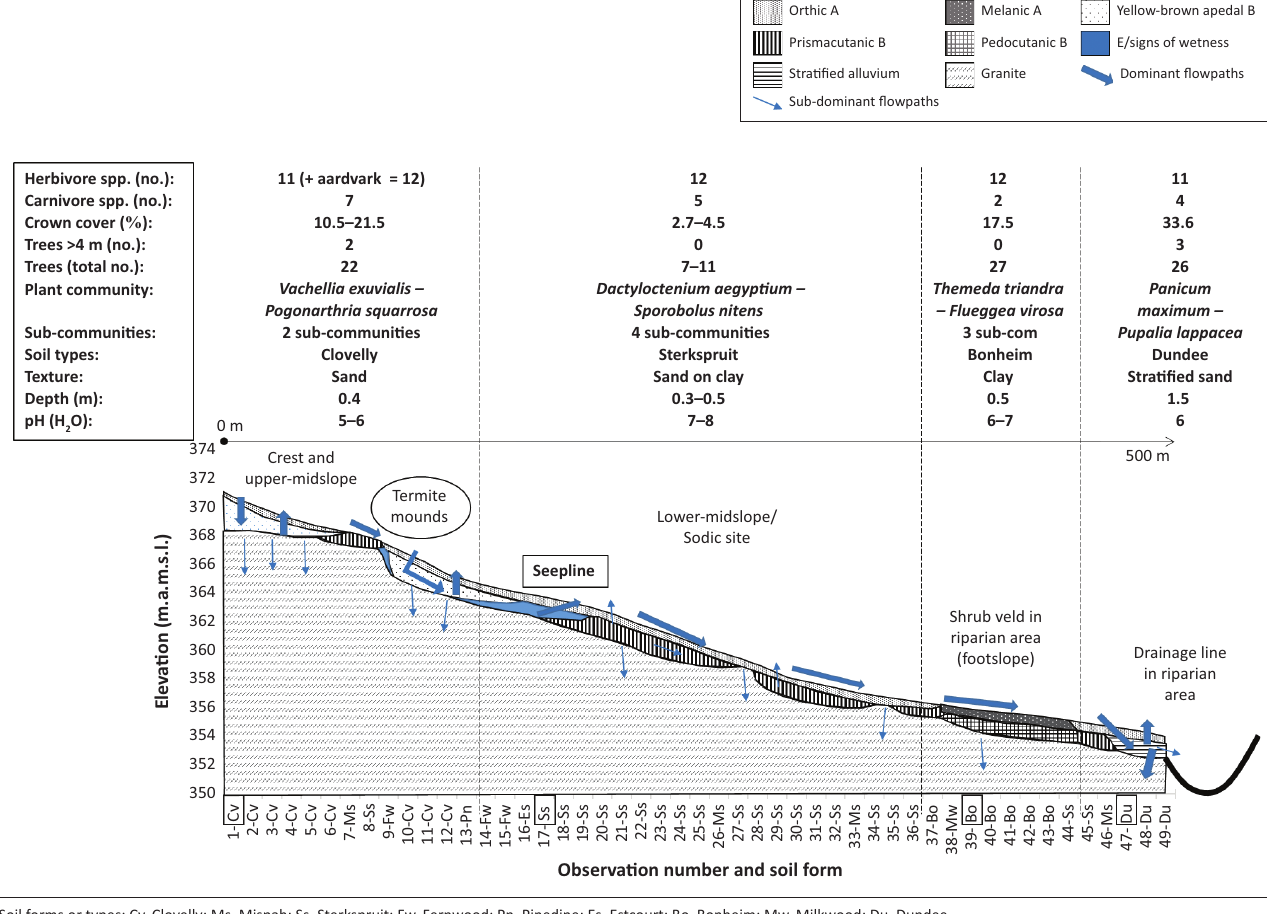
FIGURE 3: Hydropedological response model, topography, soil types and properties, plant communities, vegetation structure (percentages and numbers of individual plants per 100 m transect) and number of mammal species in each zone on the catena. Numbers of mammals may seem similar between catenal zones, but do not necessarily fully overlap in species composition (Janecke & Bolton 2020). The hydropedological response is described in detail in Bouwer et al. (2020) and Van Tol et al. (2020), soil forms (blocks indicate modal profiles where more detailed analyses were done) are described by Bouwer et al. (2020), the plant communities are described in Theron et al. (2020) and the vegetation structure is described in Janecke